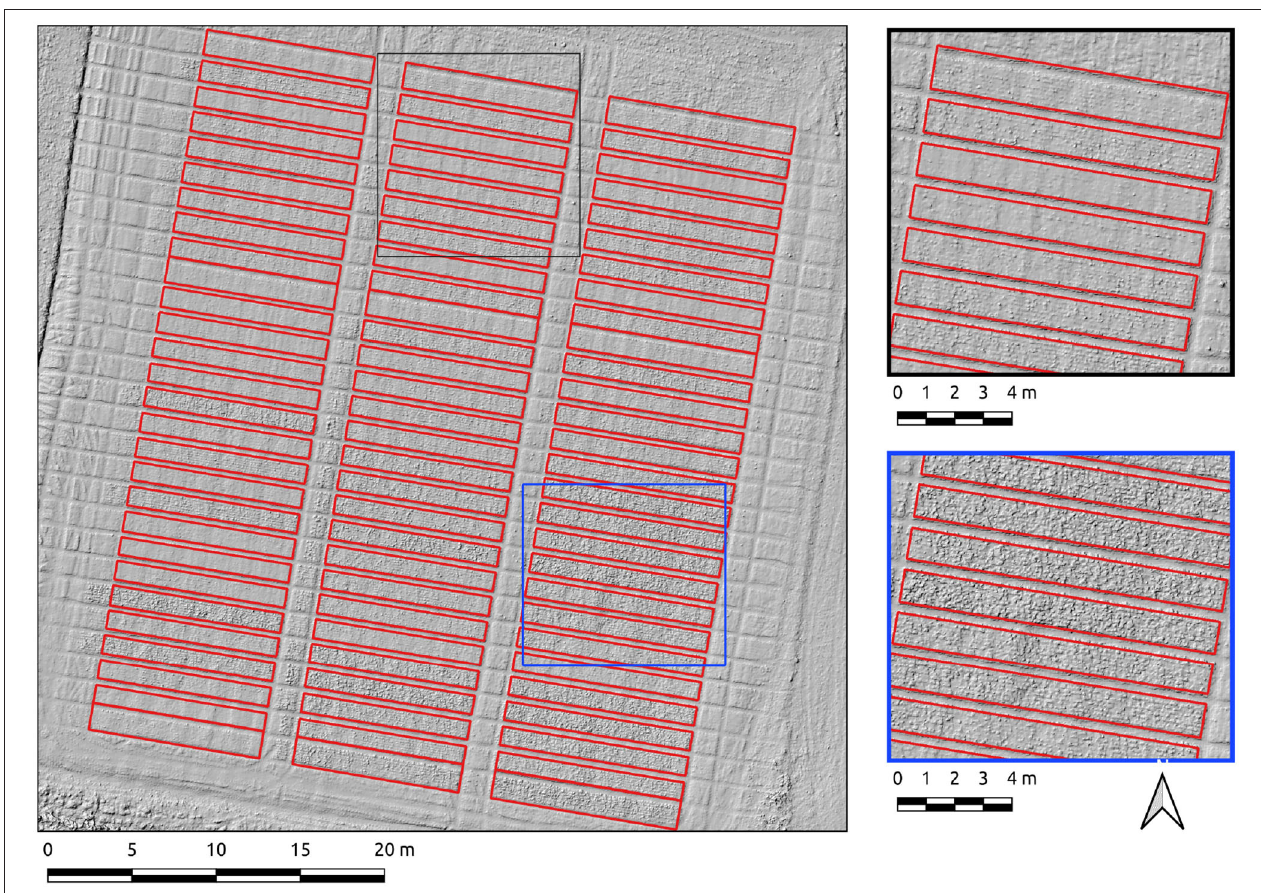
FIGURE 8 | Segmentation results on the Cae Rasus 4 site crop plots set using the Canny-based approach.